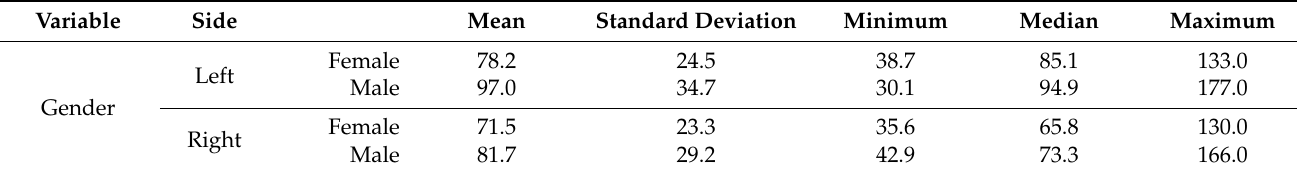
Table 3. Position and dispersion measurements of supra agger cell by